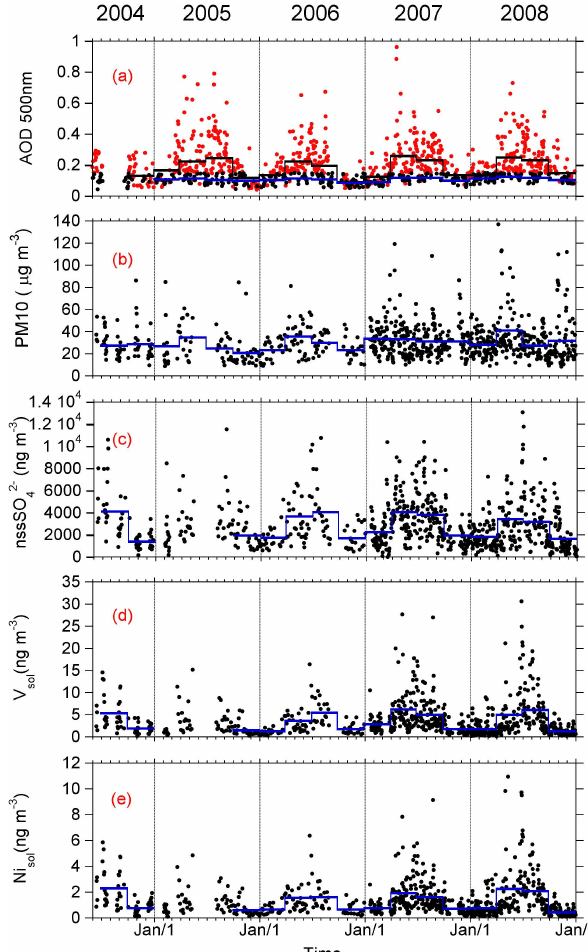
Fig. 3. Temporal evolution of AOD, PM 10 , nssSO 2 − Ni sol , at Lampedusa island. Blue lines in plot (b) , (c) , (d) , and (e) represent the three months mean. Red dots in the plot a are related to Saharan dust events chosen as AOD > 0 . 15 and a < 0 . 5 (Pace et al., 2006). Black dots represent the remaining days. In this plot the dark line represent the AOD three month average, the blue one the three month mean excluding the Saharan dust event (i.e. calculated over the black